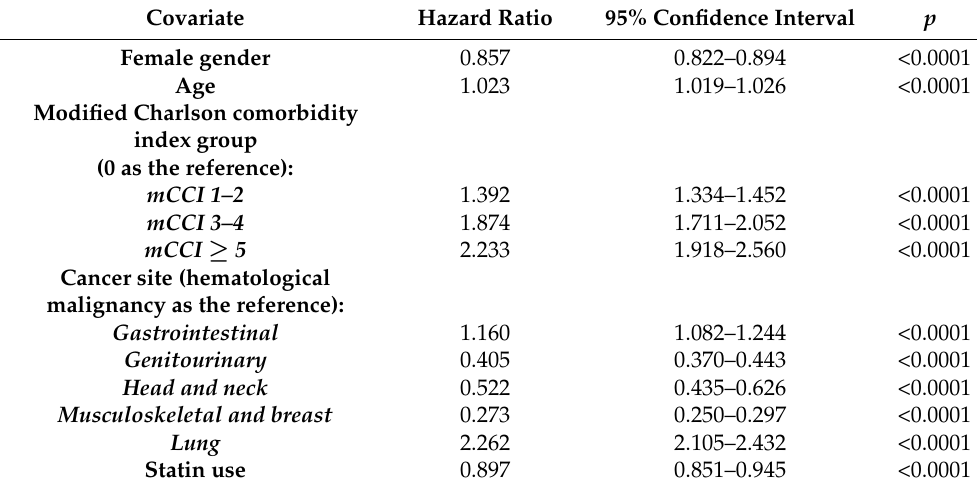
Table 2. Summary of the Cox proportional hazard model assessing the effect of covariates on the overall